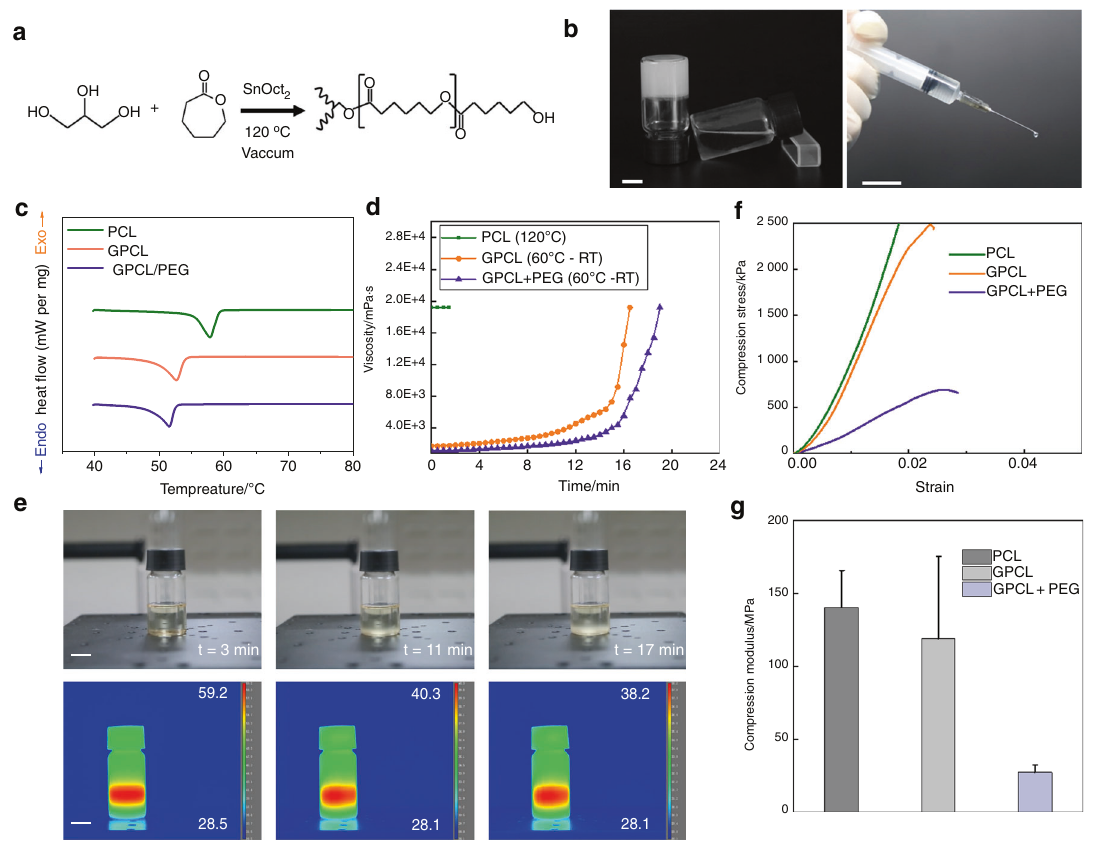
Fig. 1 Synthesis and characterization of GPCL. a Synthesis of GPCL. b The polymer was a liquid when cooled to room temperature. c Melting temperatures of GPCL polymers, as measured by DSC. d The viscosity of the polymer during cooling from 60 °C. e Thermal and optical images of GPCL/PEG cooling from 60 °C to room temperature. f , g Compressive strength and modulus of the polymers at 37 °C. Scale bars: 1 (Fig. 1d), and GPCL had a viscosity of less than 3.5 × 10 3 mPa ‧ s, which was consistent with smooth injection. Furthermore, the addition of PEG also decreased the viscosity of the polymer. The thermal analysis results showed that GPCL/PEG maintained its liquid state even when the temperature was less than the melting point during cooling (Fig. 1e). The long duration at a low viscosity would enable clinicians to inject the material or mix drugs. After suf fi cient cooling (~20 min) and solidi fi cation of GPCL, its compressive modulus was 120 kPa at body temperature (37 °C), which was comparable to that of unmodi fi ed PCL (140 kPa) (Fig. 1f – g). GPCL/PEG had a modulus of 8 kPa; therefore, the